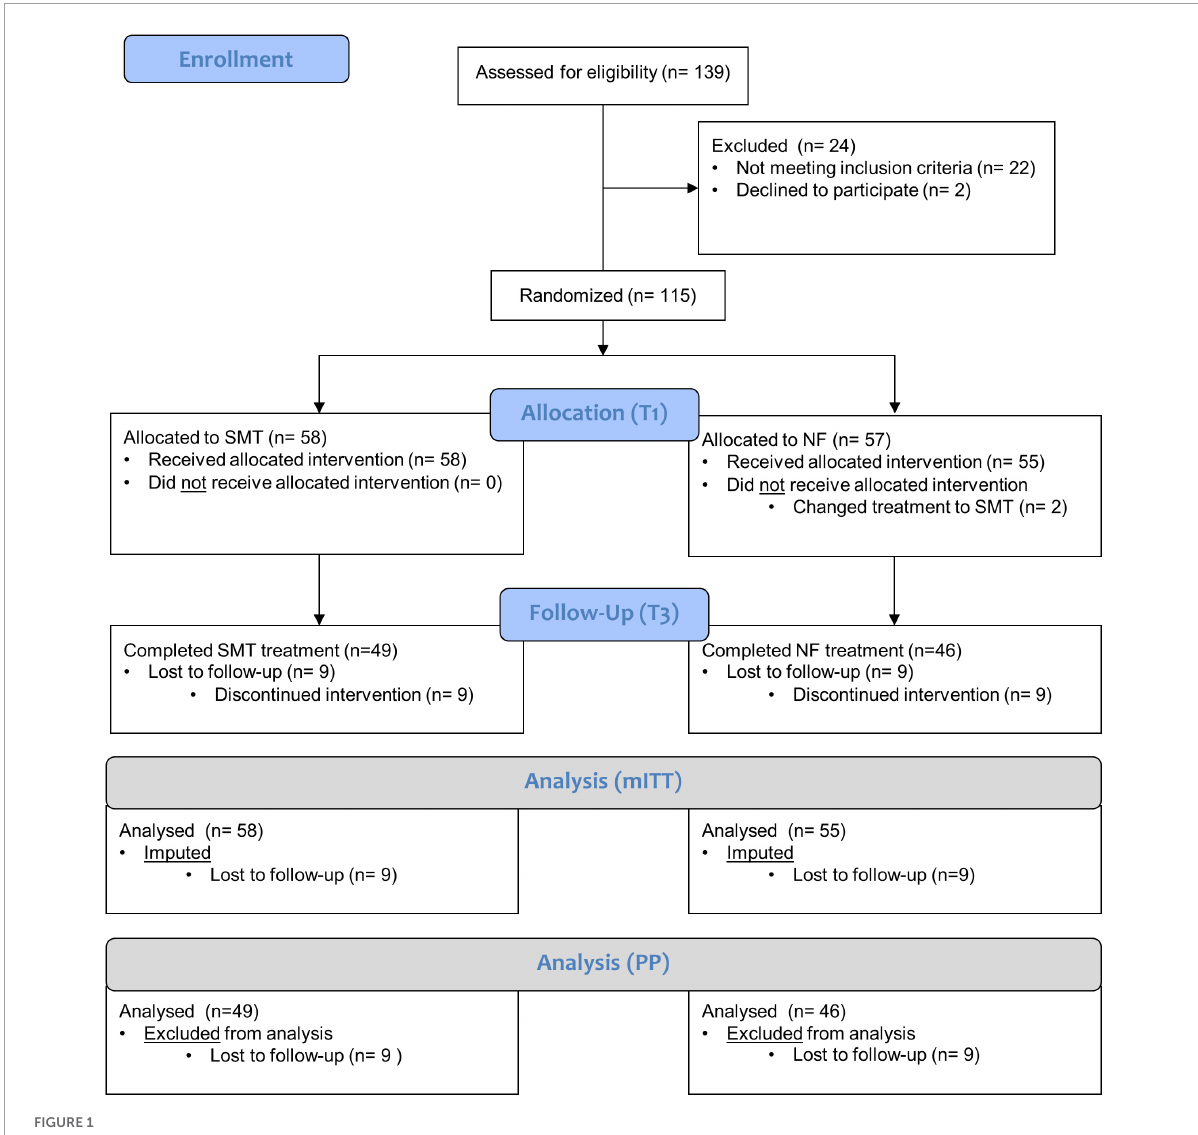
FIGURE1 CONSORT flow-chart. For the current study, n = 139 children with ADHD were assessed for eligibility, of which N = 115 fulfilled inclusion criteria, gave final informed consent for participation and were randomized into groups receiving SMT ( n = 58) or NF ( n = 57) as the intention to treat (ITT) sample. Of these, n = 2 participants randomized into the NF group changed treatment to SMT and were excluded from modified mITT analyses. In the course of the intervention, n = 9 participants were lost in each group until follow-up (T3). Consequently, the mITT analyses comprises n = 58 children receiving SMT and n = 55 receiving NF whilst the per Protocol analyses comprises n = 49 children receiving SMT and n = 46 receiving NF that actually completed their